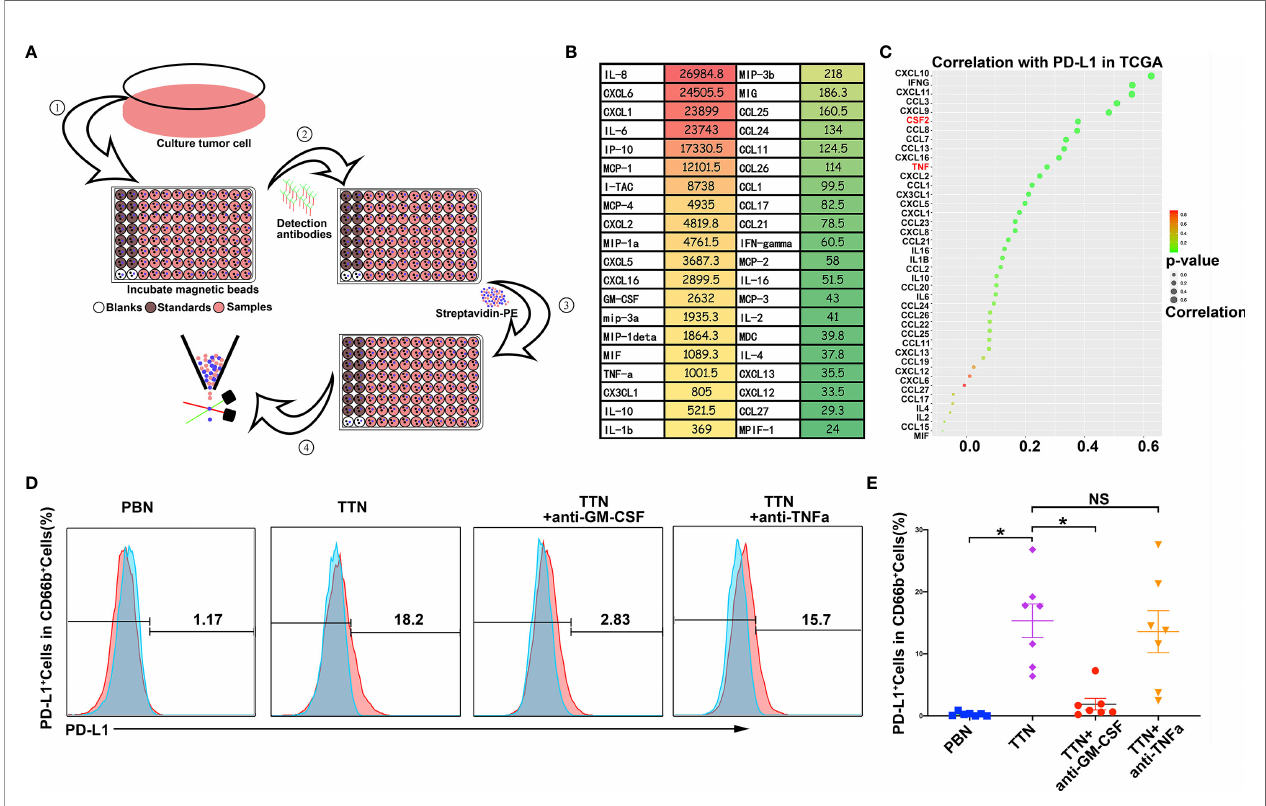
FIGURE 5 | Tumor-secreted factor GM-CSF triggered PD-L1 expression on neutrophils. (A) The work fl ow of Bio-Plex Multiplex Immunoassays. (B) The heatmap of supernatant cytokines pro fi le in the tumor cell line T24 cultured for 48 hours. The color represents the concentration (ng/ml) of cytokines. Green, low concentration; Red, high concentration; Yellow, middle concentration. (C) The dotplot showing the correlation between PD-L1and cytokines in the TCGA database. P -values were determined using Pearson ’ s correlation coef fi cient test. The color represents P -values Green, low P -values; Red, high P -values, the size represents correlation values. (D, E) The ef fi cacy of blocking GM-CSF and TNF a in ablating the expression of PD-L1 on TTNs. (D) Representative experiments (n=7). (E) Summarizes the change in the percentage of PD-L1+ TTNs and add blockade antibody of GM-CSF and TNF a into tumor cell line T24 supernatant-treated TTNs. Error bars represent the mean ± SEM. * P < 0.05 was considered a signi fi cant difference, NS was no signi fi cance (Student ’ s t-test, paired parametric